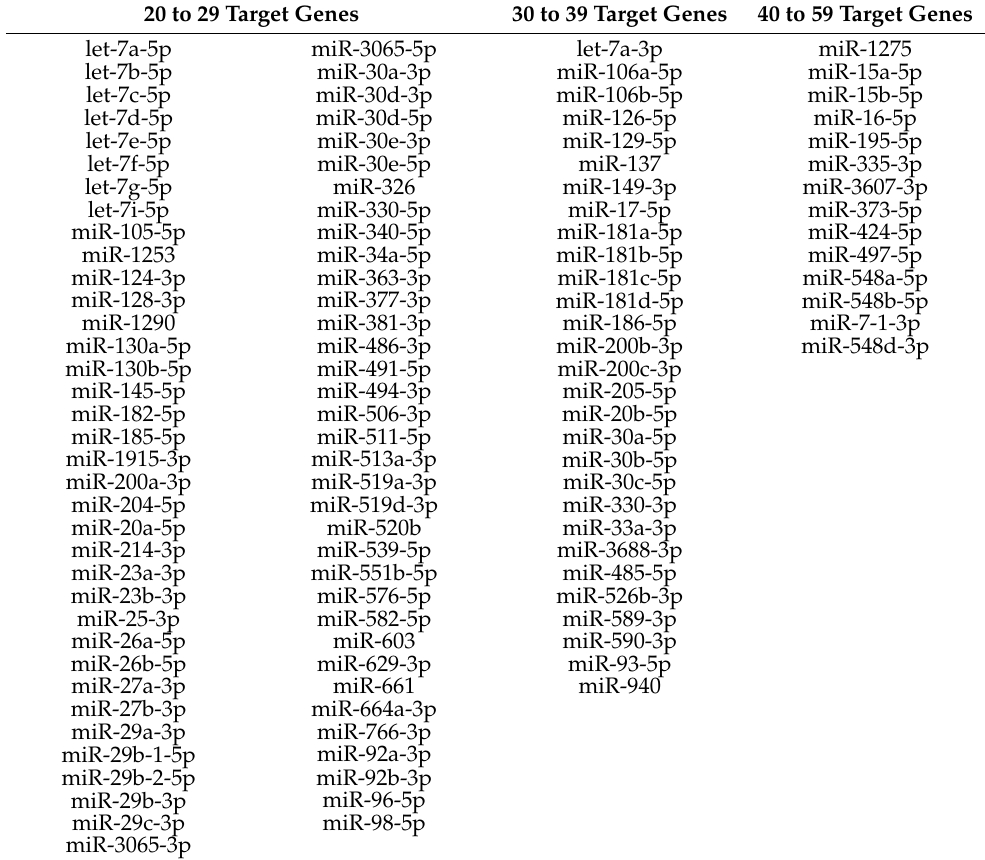
Table 4. List of miRNAs found to interact with 20 to 59 potential target